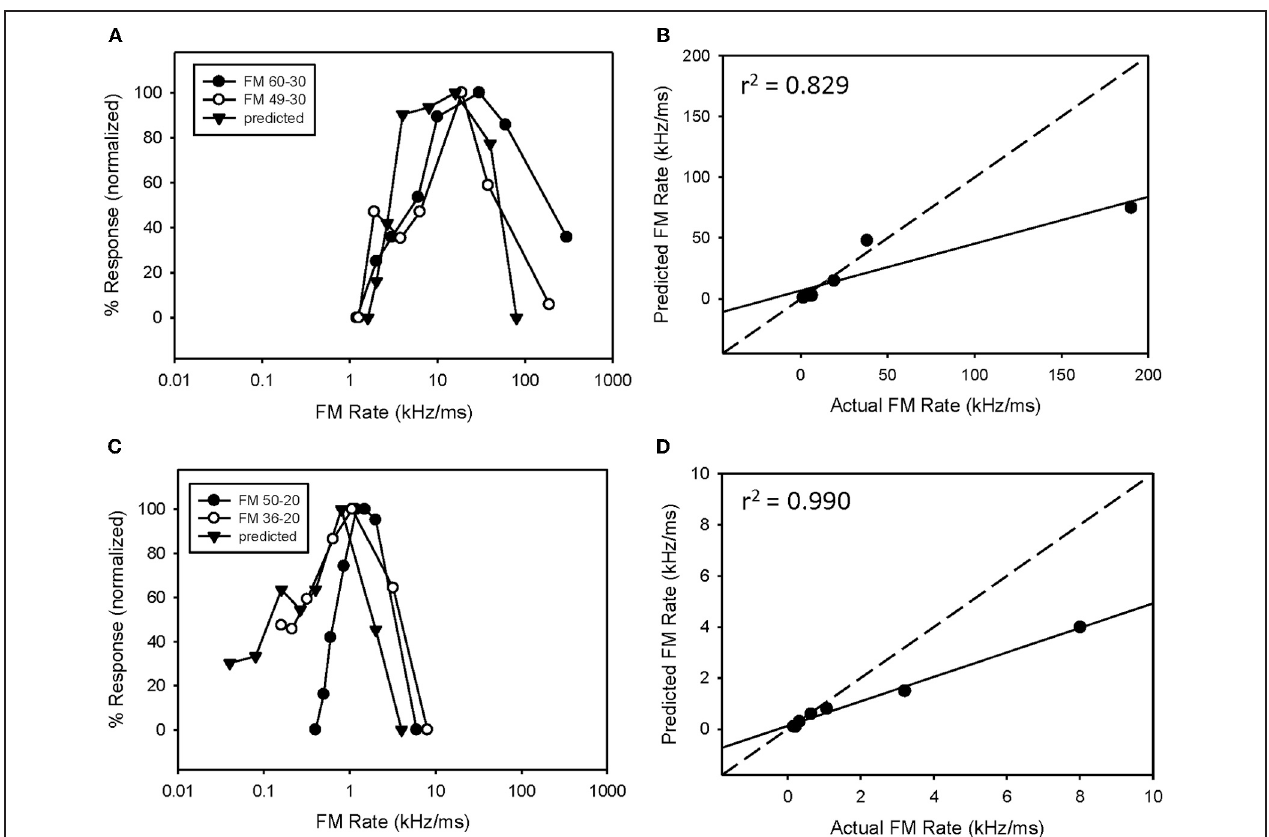
FIGURE 5 | In neurons expressing HFI, predicted responses were compared to FM sweeps both in the presence and absence of HFI by eliminating the high-frequency region from the sweep. The effect of removing HFI ranged from a minimal change in the FM